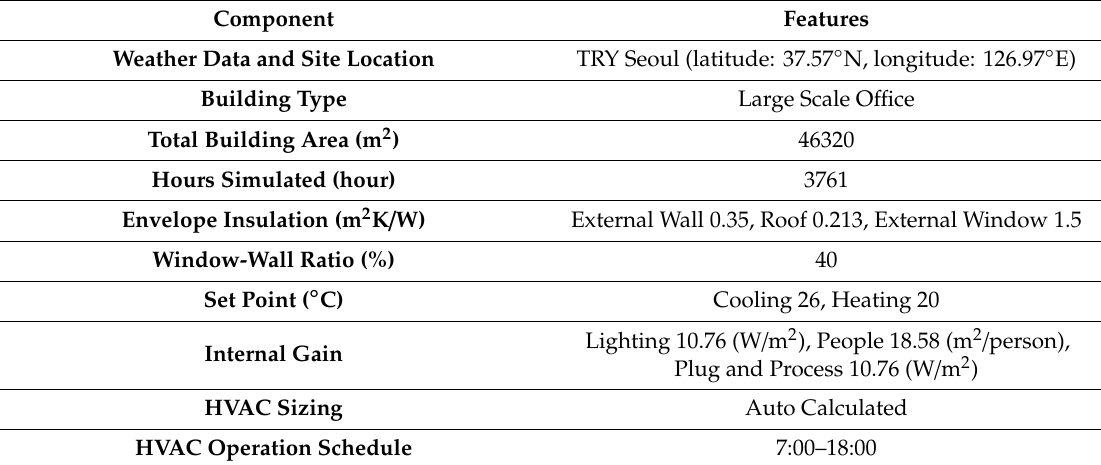
Table 1. Simulation condition of reference building large scale o ffi